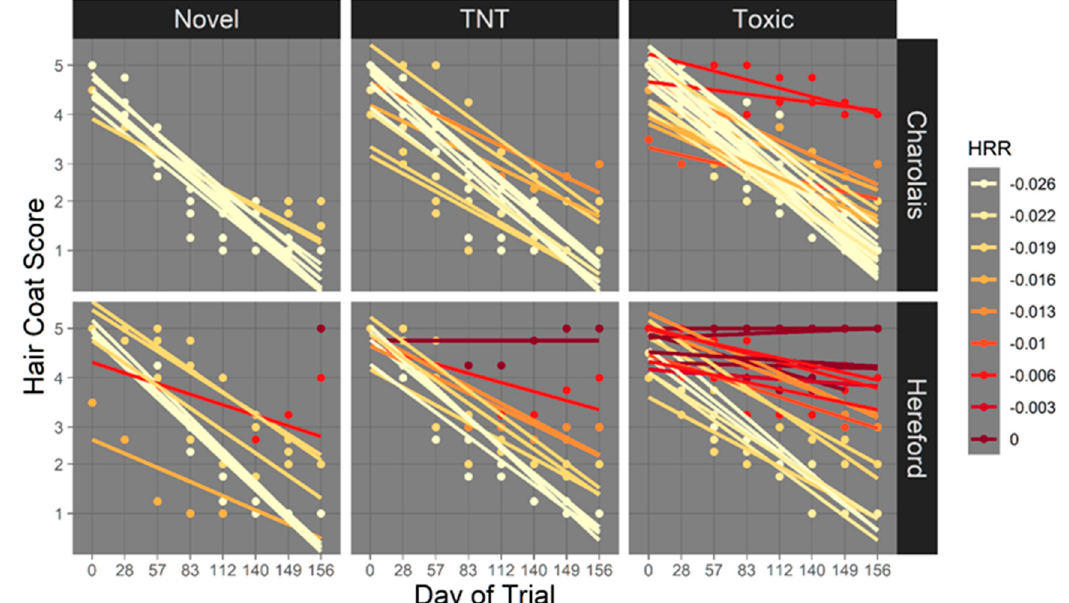
Figure 3. Individual cow variation in hair reduction rate (HRR) by fescue type and sire breed. Cow hair coat score (HCS) was scored monthly using the system described by [30] [1 = slick summer coat (100% shed) to 5 = full, thick winter coat (0% shed)]. HRR was calculated by performing a sliding window average of HCS to get adjusted HCS for each time point. Adjusted HCS from day 0 and day 156 were used to calculate rate of hair shed over time, of HRR. Each line represents the change in HCS over change in time (days) for each cow. The top and bottom panels represent rate of hair reduction for Charolais- and Hereford-sired cows ( p < 0.0001) on novel fescue, toxic-novel rotation (TNT), and toxic fescue, respectively ( p < 0.0004). Variability on novel fescue within the Herefords may indicate across-family variability in hair shedding. Variability in shedding in both breeds on TNT and toxic pastures may indicate genetic differences across families when exposed to fescue mycotoxins.